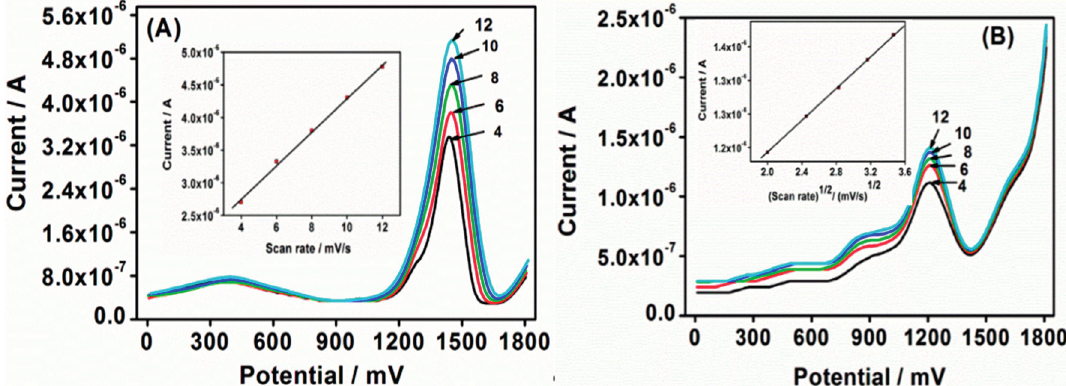
Figure 4. ( A ) AC voltammograms scan rate dependence of Au|G3PPT-co-P3HT sensor recorded in the absence of PHE in 0.1 mol/L Bu 4 NClO 4 /CH 3 CN; ( B ) The AC voltammograms scan rate dependence in the presence 3.0 × 10 –3 µmol/L PHE in 0.1 mol/L Bu 4 NClO 4 /CH 3 CN/H 2 O (numbers on the diagrams are scan rate